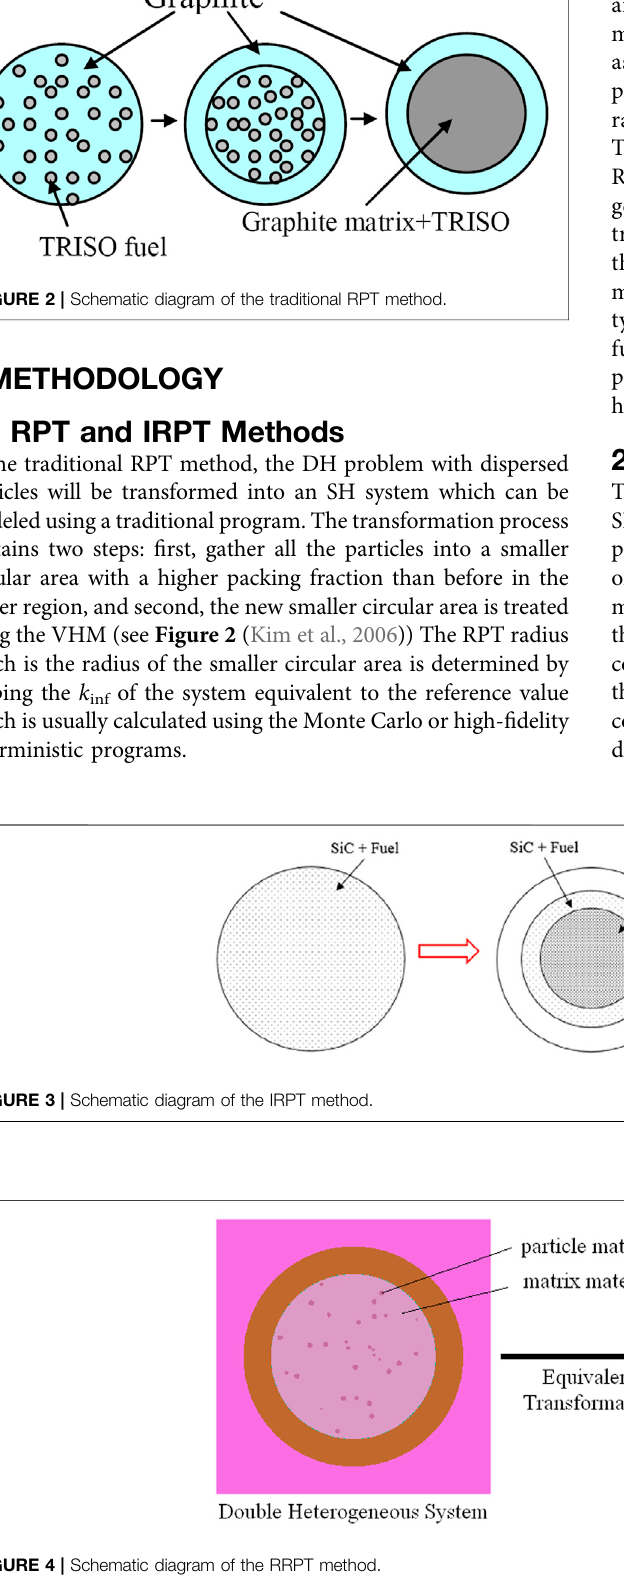
FIGURE 4 | Schematic diagram of the RRPT